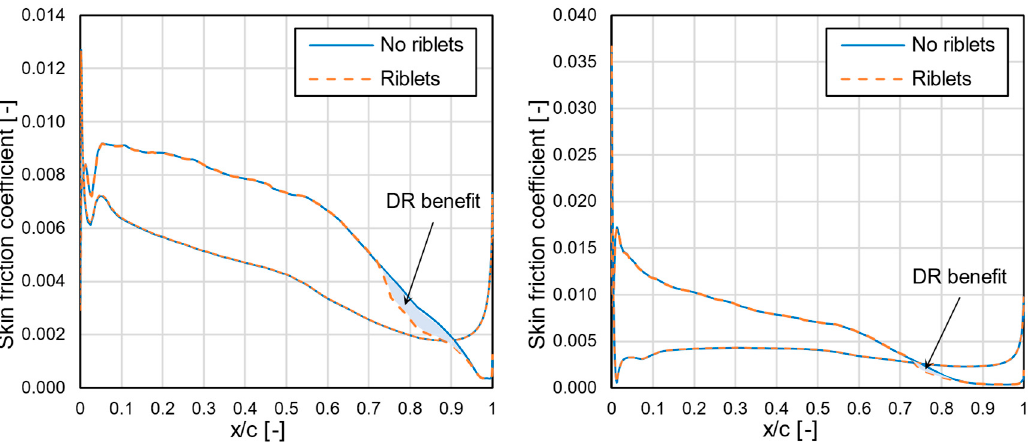
Figure 14. Skin friction on the MAC airfoil for loiter conditions at 0° ( left ) and 8° ( right ) AoA.